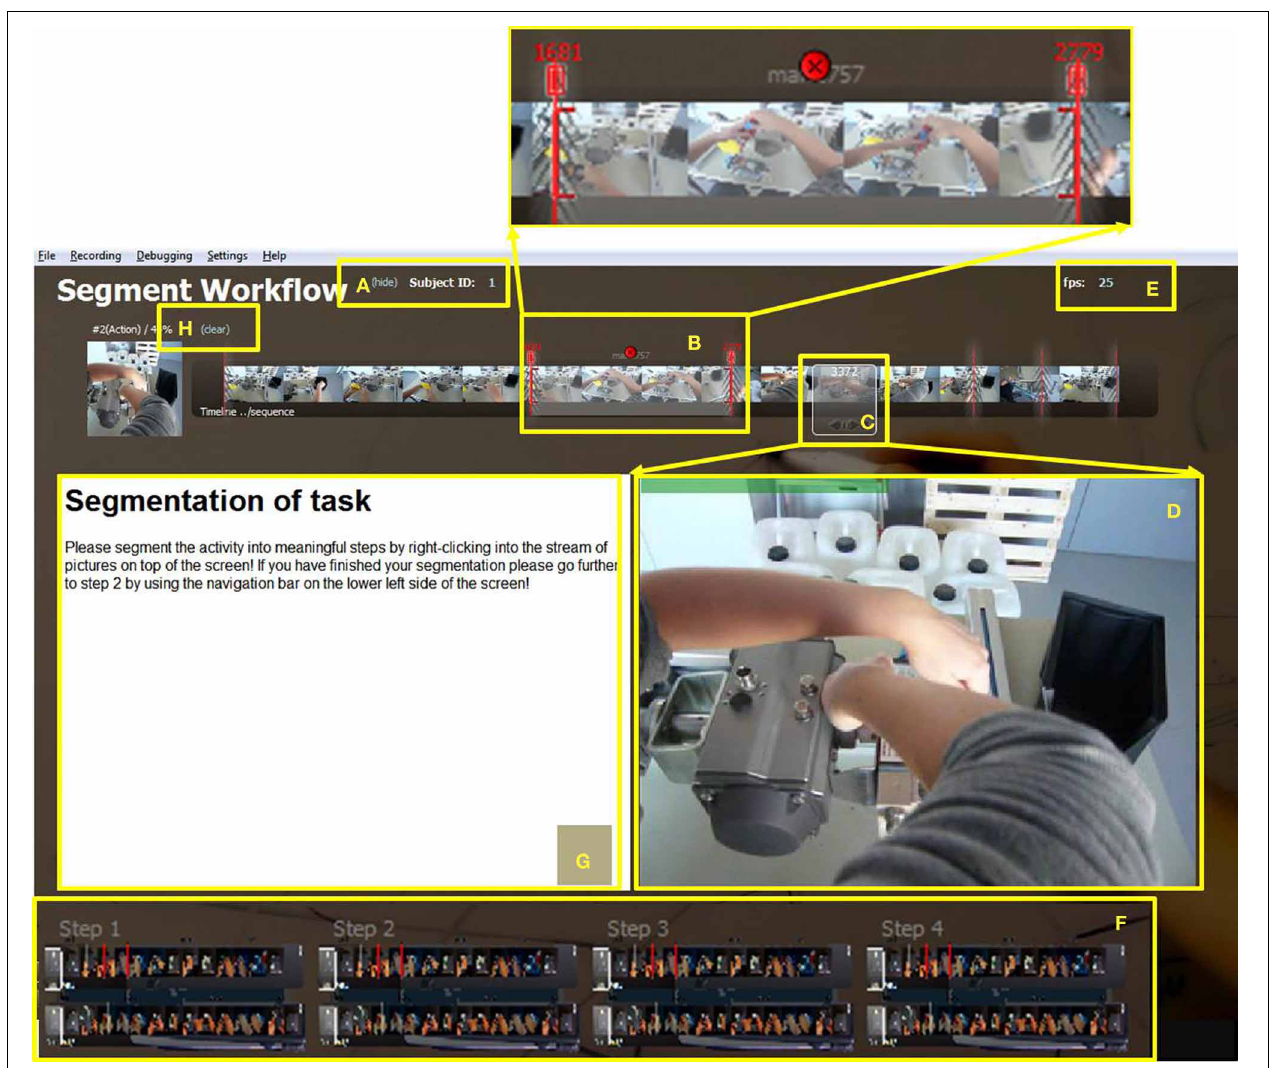
FIGURE 1 | Screenshot of start screen where segmentation into appropriate instructional steps takes place. The subject ID (A) may be entered and hidden here. (B) Start and end frames of a step are indicated by two red marks which may be used to drag the boundaries (additionally amplified on top of this figure). The chosen step can be deleted by clicking the red circle in the middle. The white window (C) highlights the current picture which appears enlarged in the center of the